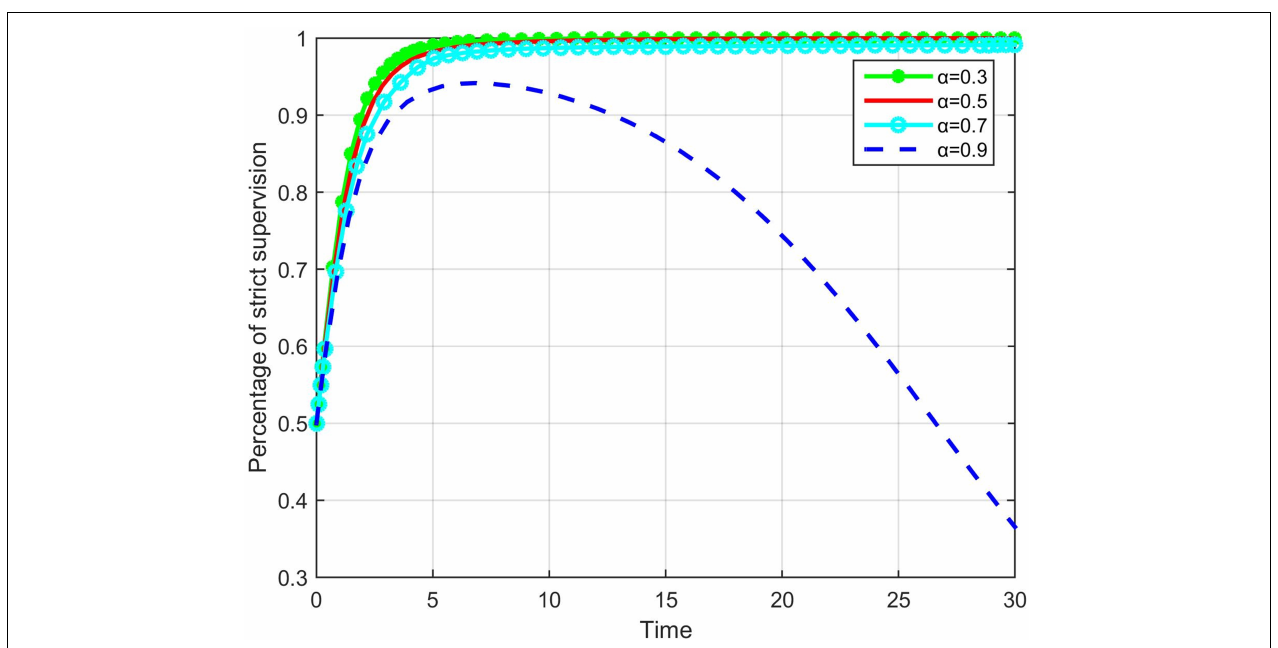
FIGURE 4 | The impact of a on the evolution trend of government strict